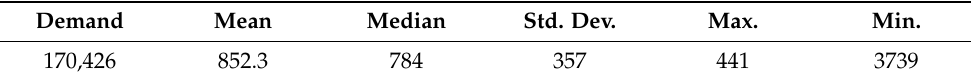
Table 3. Descriptive statistic of demand covered in the reference scenario, by parking space.